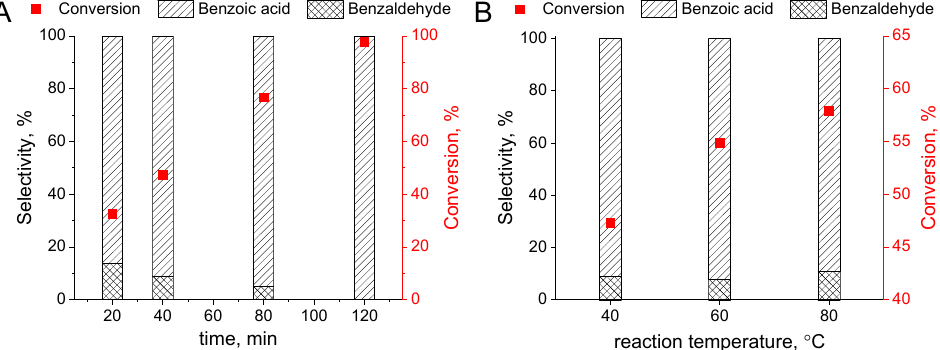
Figure 9. Activity and selectivity of Au-CeO 2 _N in benzyl alcohol oxidation after different reaction times at 40 °C ( A ) and after 40 min of reaction at different temperatures ( B ).